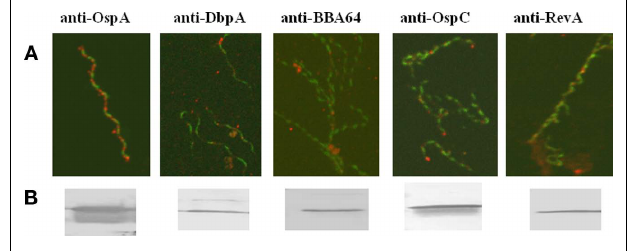
FIGURE 1 | Production of proteins from cultured B. burgdorferi . (A) Representative images of immunofluorescent dual staining of organisms with the specific mAb (noted above panels) and anti- B. burgdorferi antibody. Punctate staining of surface proteins are labeled red; whole cell B. burgdorferi are stained green. (B) Immunoblots of B. burgdorferi lysates using the specified